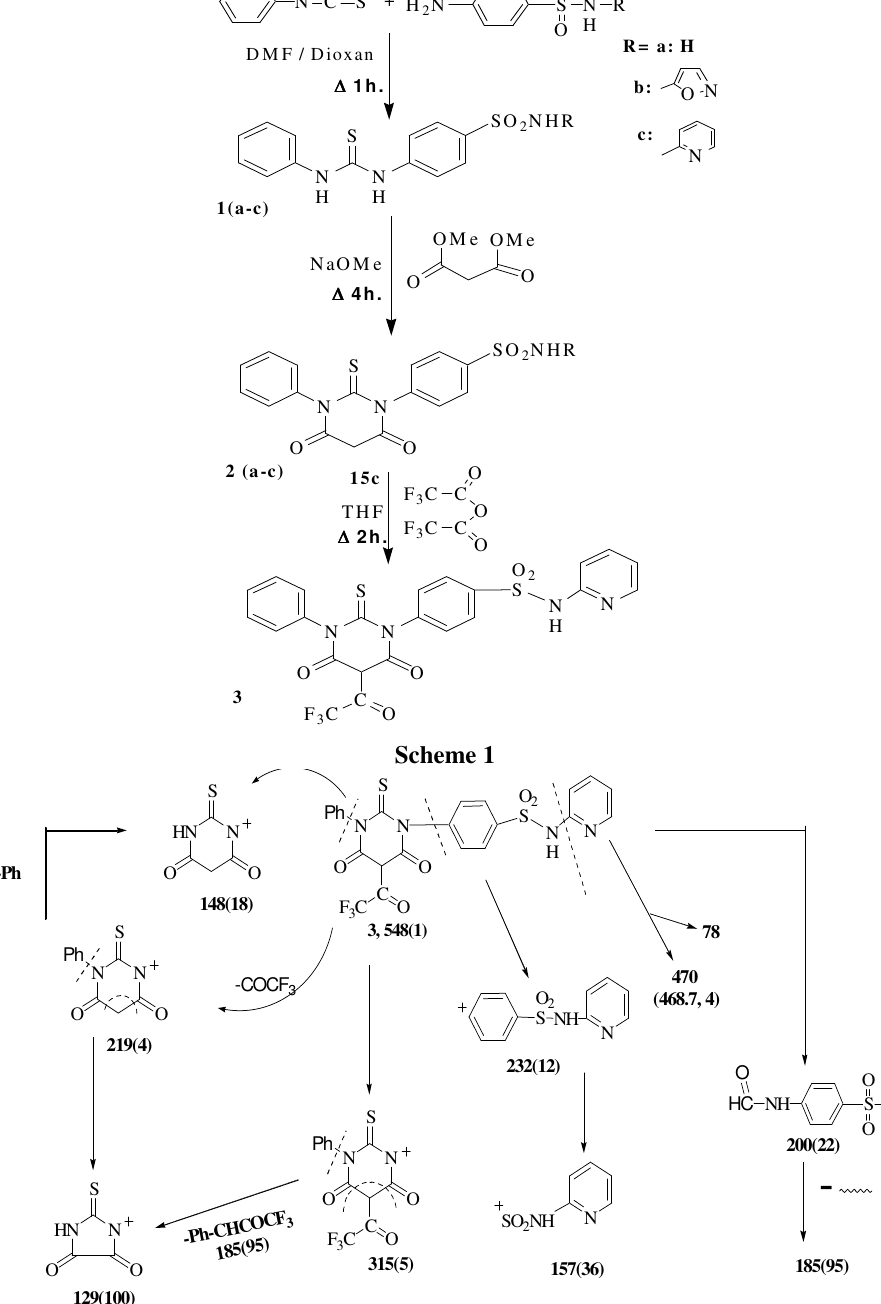
Figure 1. Mass fragmentation pattern of compound